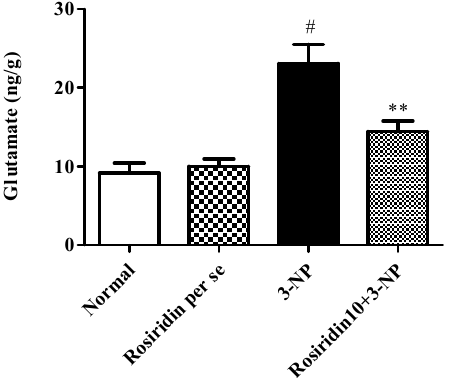
Figure 9. Effect of rosiridin on glutamate activity. Values are expressed as the mean ± SEM (n = 6). Values are statistically significant at p < 0.05 (one-way ANOVA followed by Dunnett’s test). Express the data ( # p < 0.05) saline vs. negative control group; (** p < 0.01) negative control group vs. treatment group.